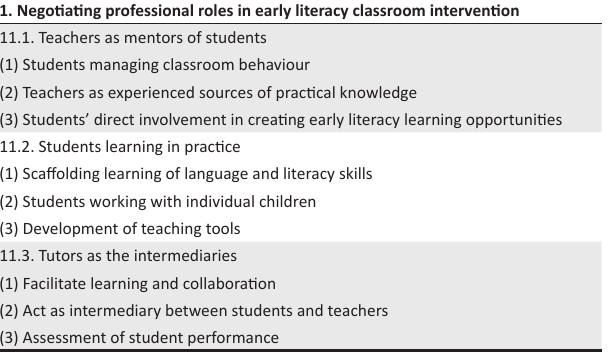
TABLE 1: Main themes and subthemes identified from the